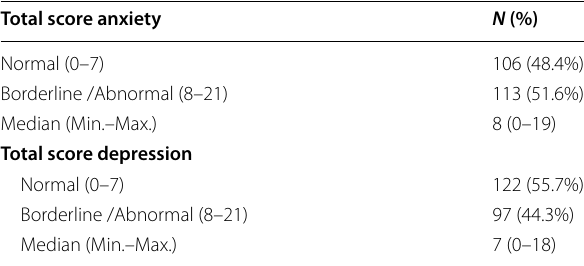
Table 2 Reported anxiety and depression according to HADS scores ( n 219) =